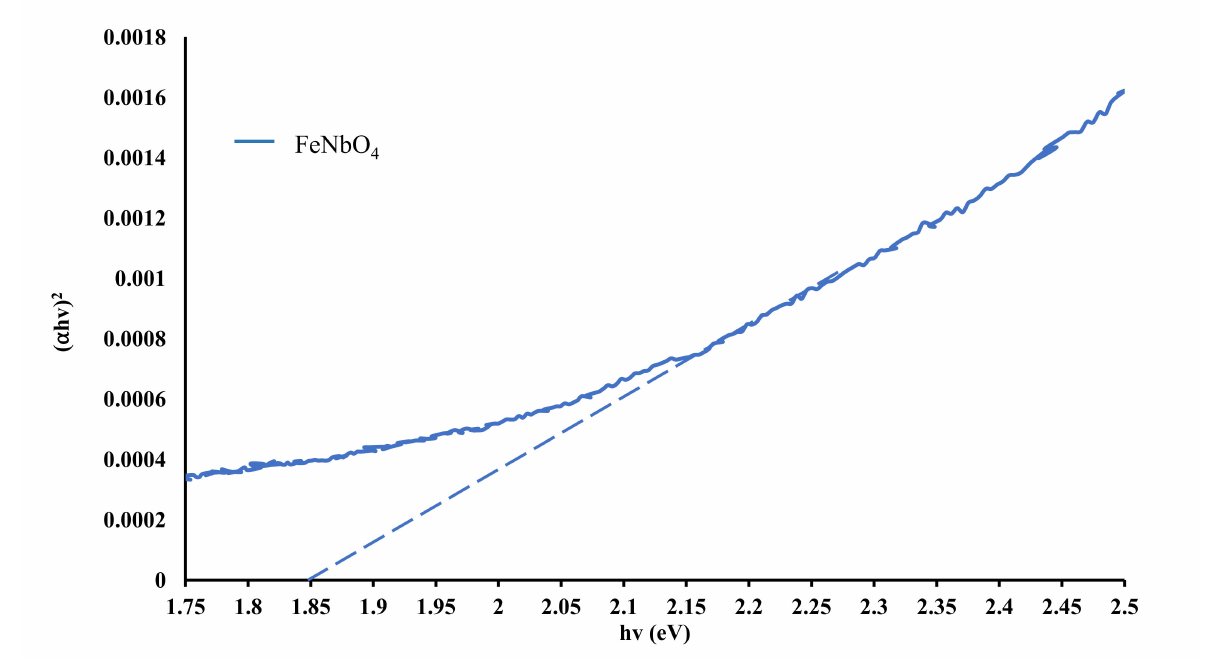
Figure 2. Tauc plot of pure FeNbO 4 .